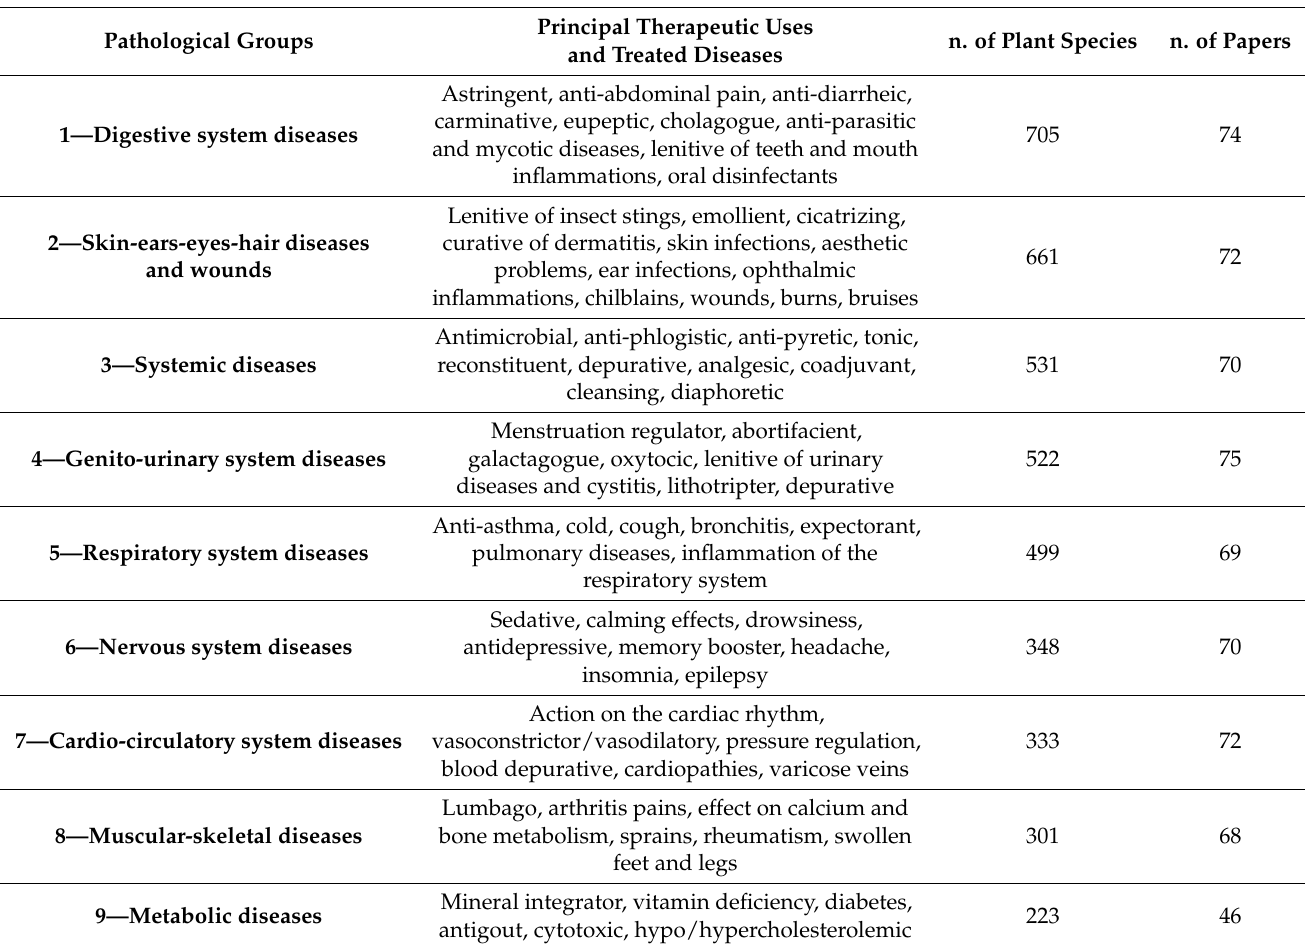
Table 2. Pathological groups and principal therapeutic applications of cited plant species. The classification used was based on the standardized descriptors reported by Cook